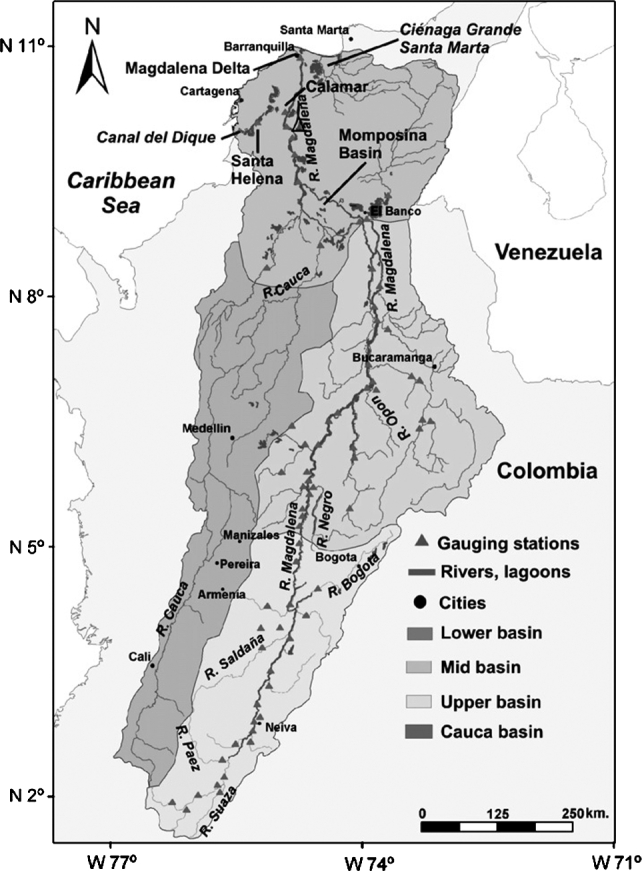
Magdalena River. Source [36].